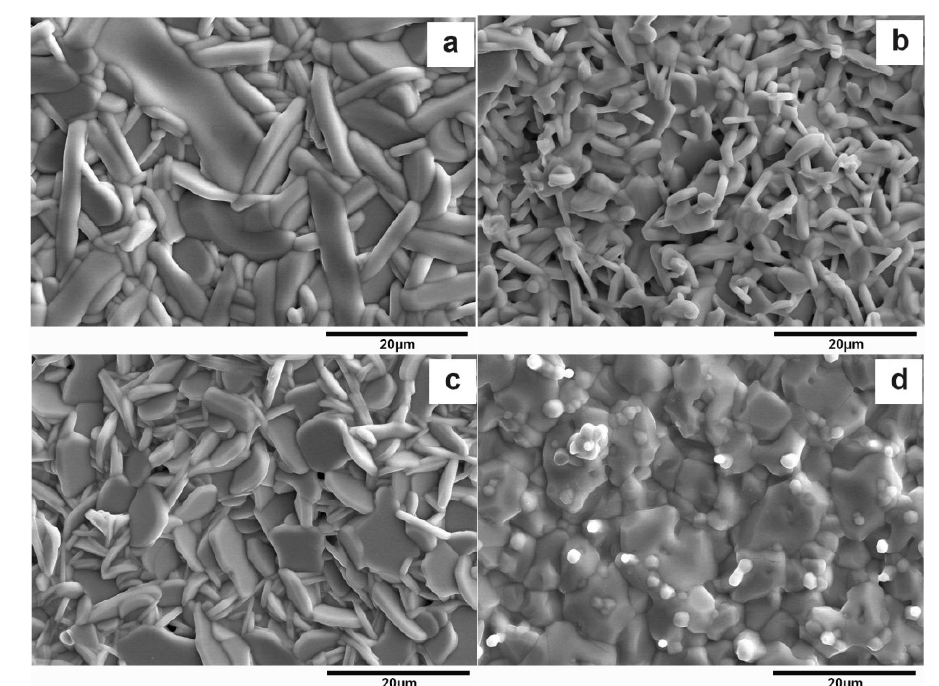
Sr TiO (a ) x = 0; ( b ) x = 0.1; ( c ) x = 0.25; 1− x x 3+δ